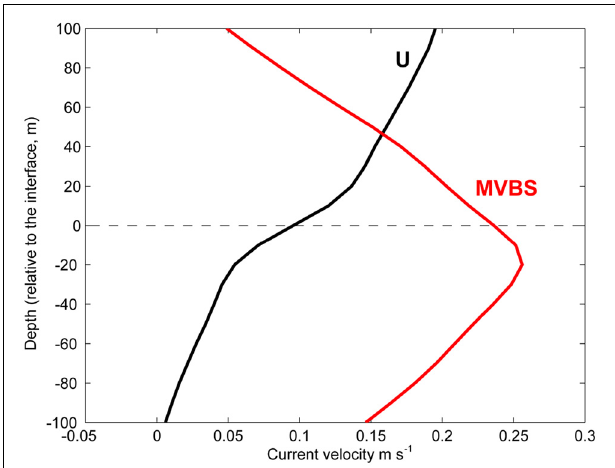
FIGURE 4 | Currents and backscatter at the ADCP mooring near the core of the Faroe Current jet. The averaged (2013–2015) zonal current velocity profiles ( U -component, black) and the normalized mean volume backscattering strength MVBS (red, not to scale), both vertically centered at the vertically shifting interface under the Faroe Current ( Figure 3